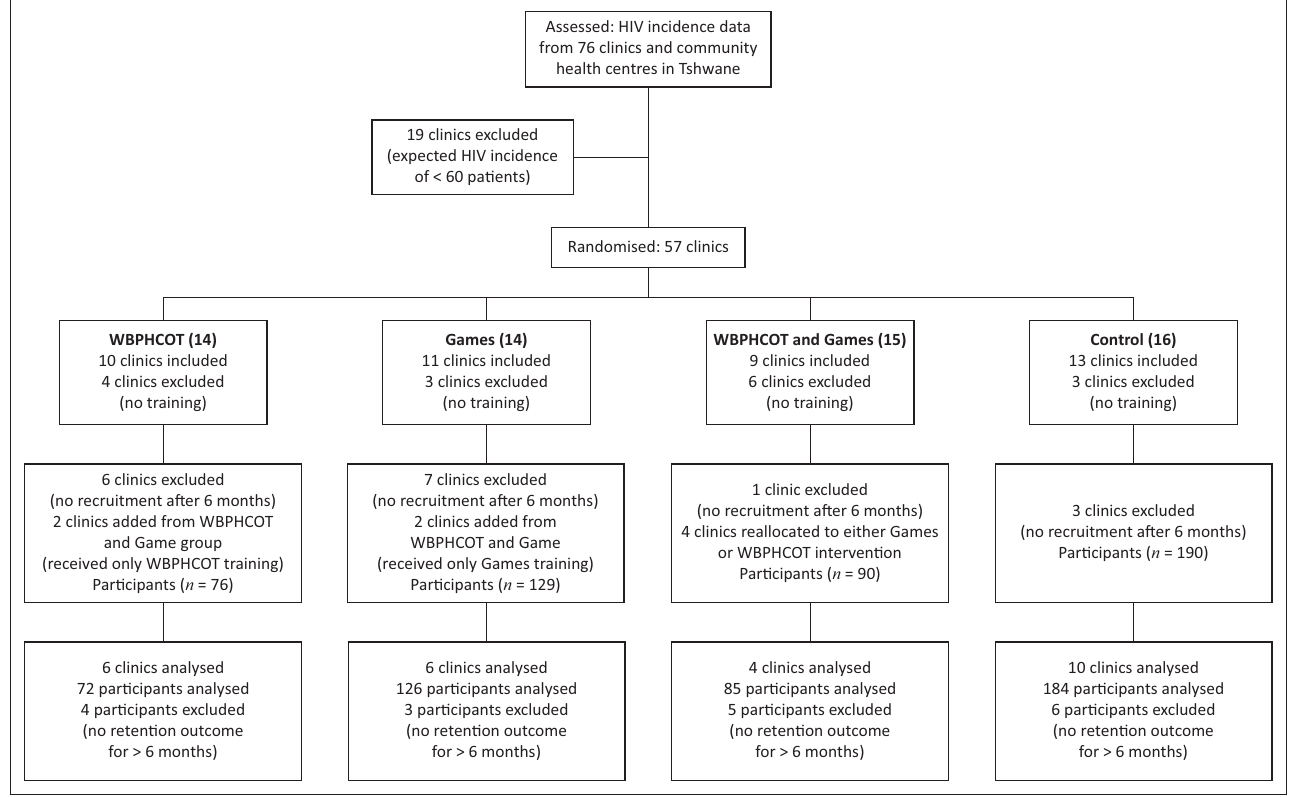
FIGURE 2: Flow diagram showing number of participants randomised, allocated, followed up and analysed.